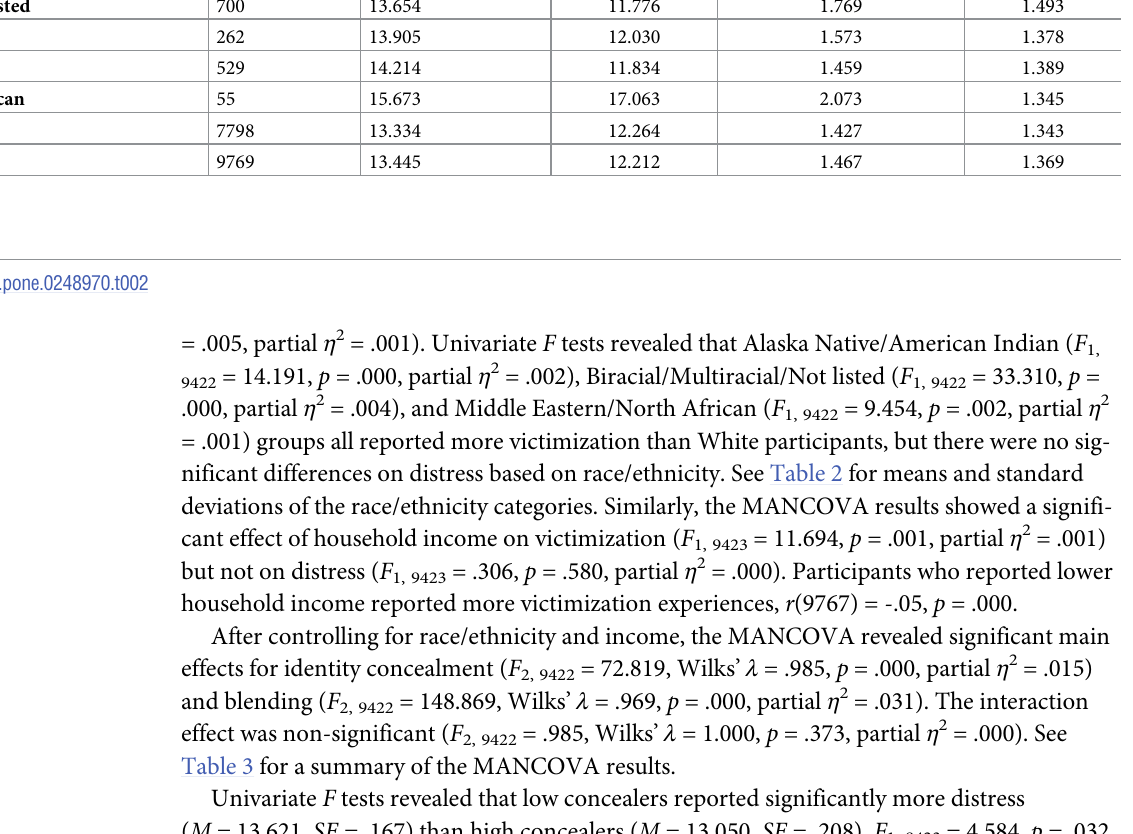
Table 3 for a summary of the MANCOVA results.